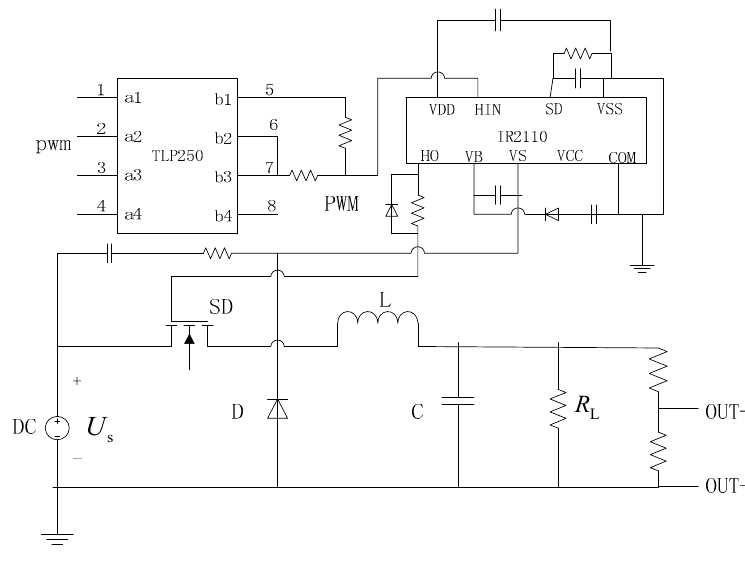
Figure 8. The schematic diagram of the hardware.